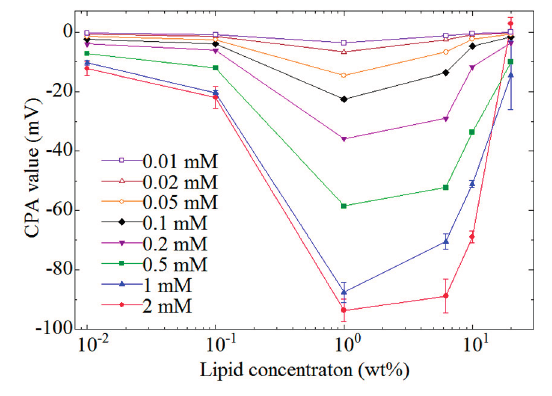
Figure 5. Relationship between CPA value and lipid concentrations. The concentrations